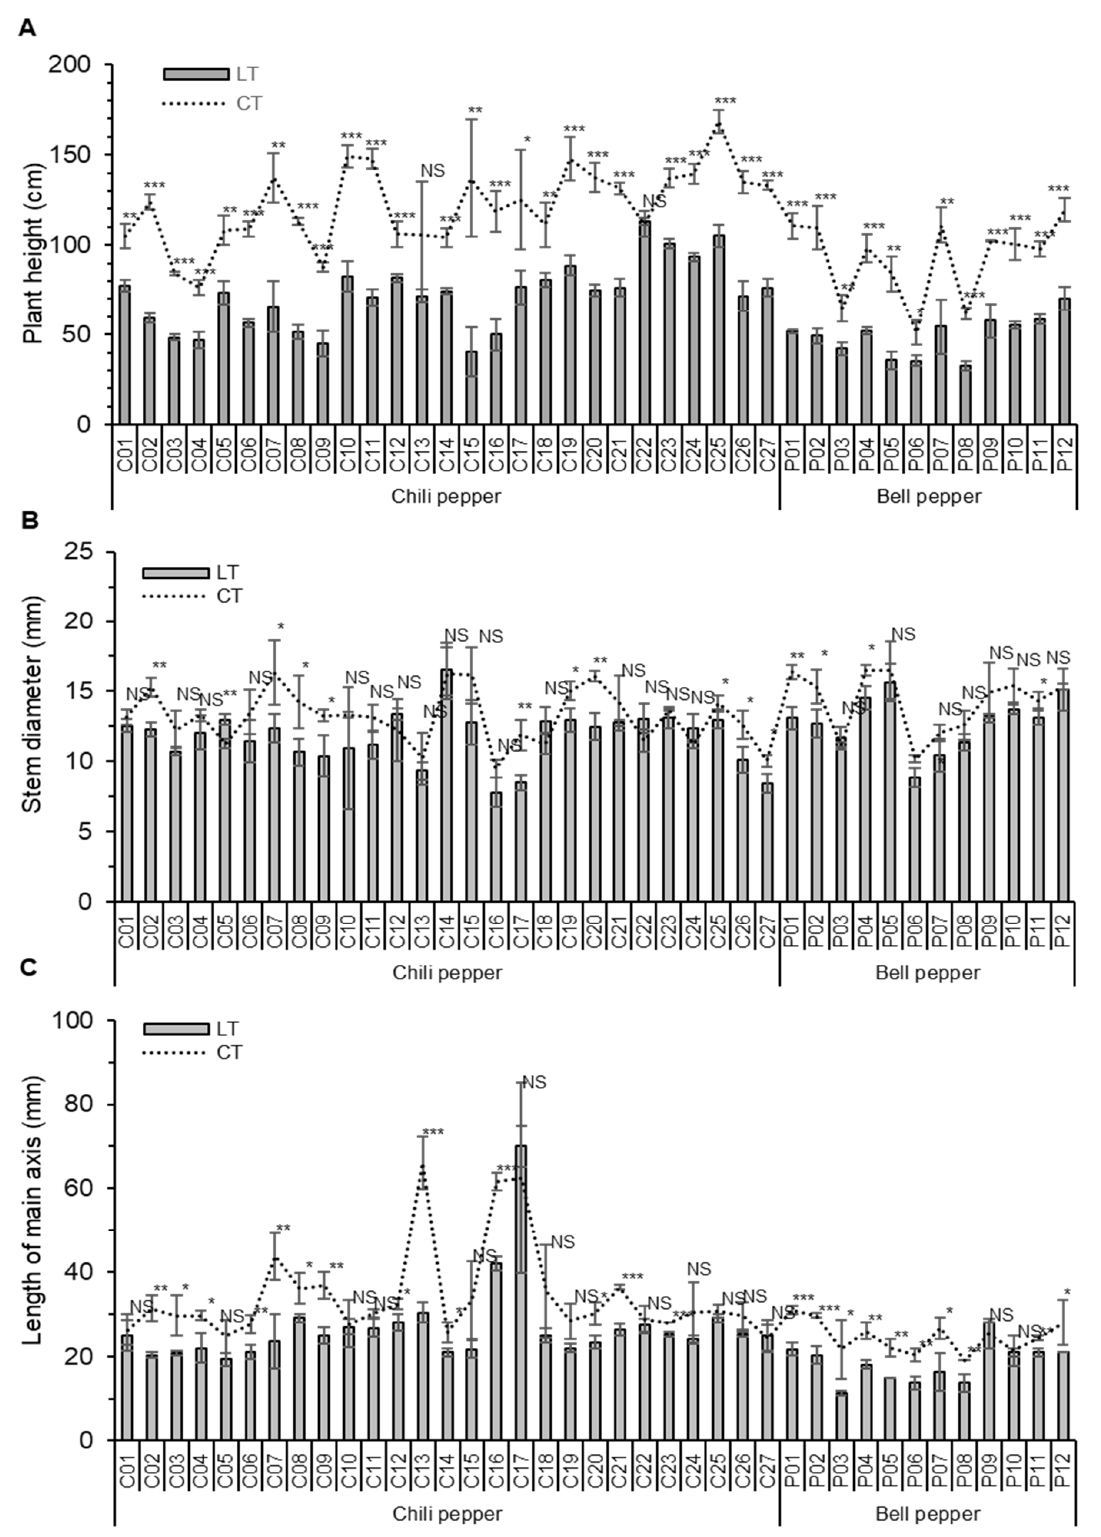
Figure 1. The evaluation of vegetative traits on ( A ) plant height, ( B ) plant stem diameter, and ( C ) length of main axis among 39 pepper accessions in LT and CT greenhouses. Plant height, stem diameter, and length of main axis were measured at 120 days after transplanting. Significant differences were evaluated with Student’s t -test with p ≤ 0.05, p ≤ 0.01, and p ≤ 0.001 and denoted by *, ** and ***, respectively. NS means not significant and bars indicate ± standard deviation ( n = 3).